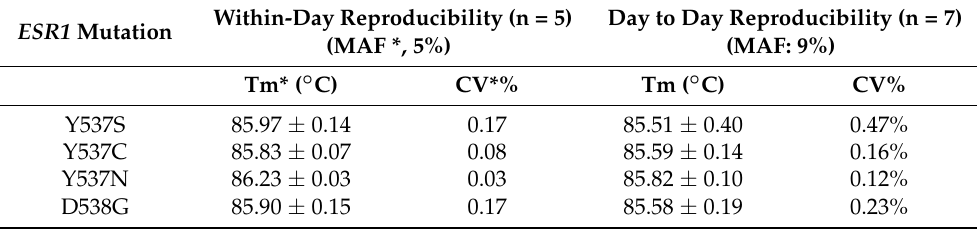
Table 1. Reproducibility of the ESR1 NAPA assay using synthetic oligos for each ESR1 mutation.